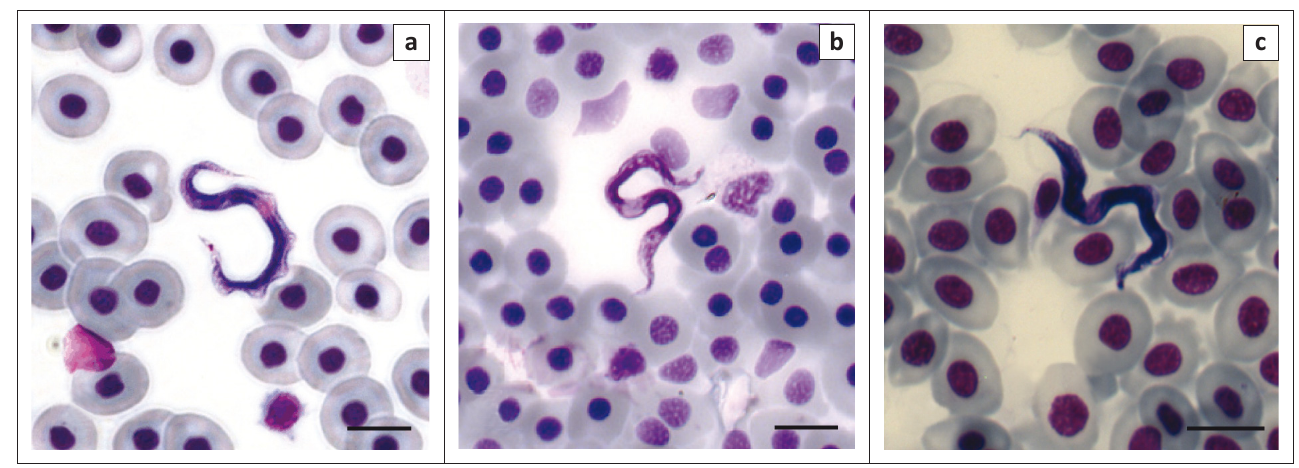
FIGURE 1: Light micrographs of Giemsa stained Trypanosoma sp. (a) Trypomastigote stage in Clarias gariepinus Burchell, 1822 blood film from the Vaal Dam, South Africa. (b) Trypomastigote stage in Clarias gariepinus blood film from the Sand River Dam, Swaziland. (c) Trypomastigote stage in Tilapia sparrmanii Smith, 1840 blood film from the Nylsvlei Nature Reserve, South Africa